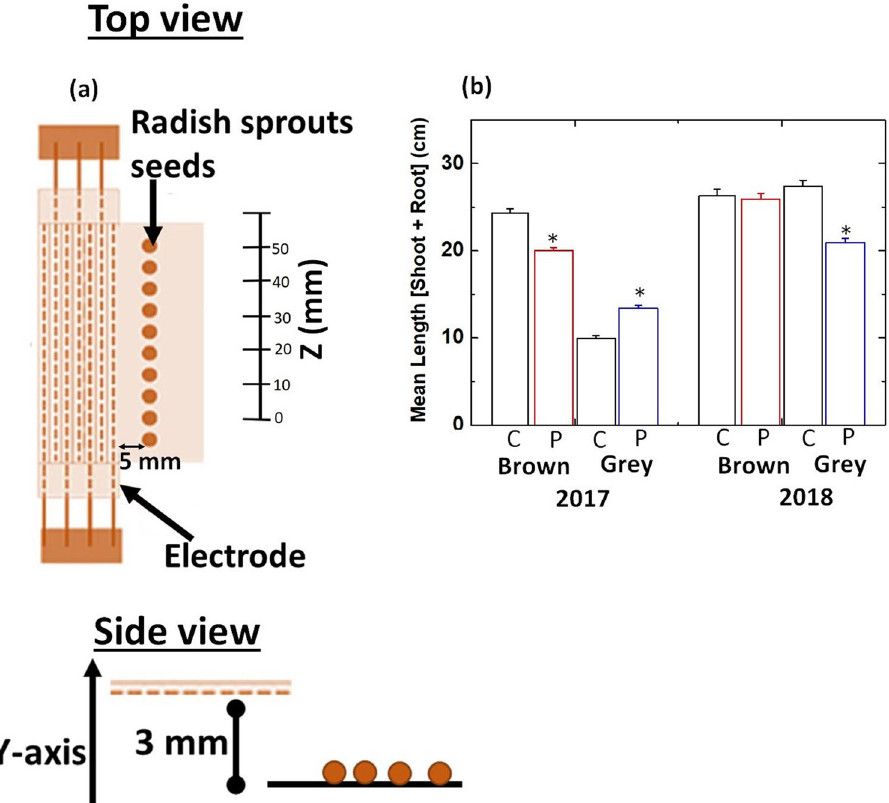
Figure 1. (a) Schematic display of radish seed position during plasma treatment (top and side view); (b) mean length of sprouts (shoot + root) germinated from control (C) and plasma treated (P) radish seeds harvested in 2017 and 2018 year. Results are presented as means ± SEM (n = 40).*Statistically significant difference in comparison to control (p ≤